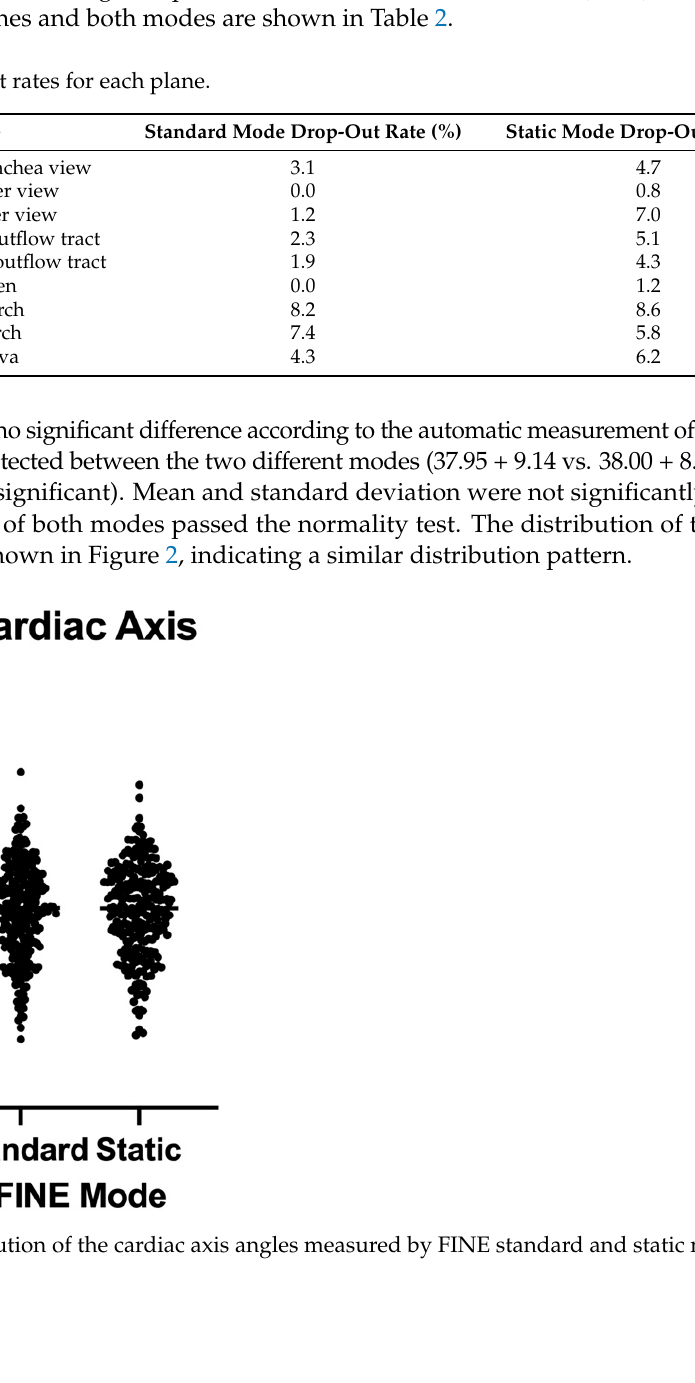
Table 2. Drop-out rates for each plane.